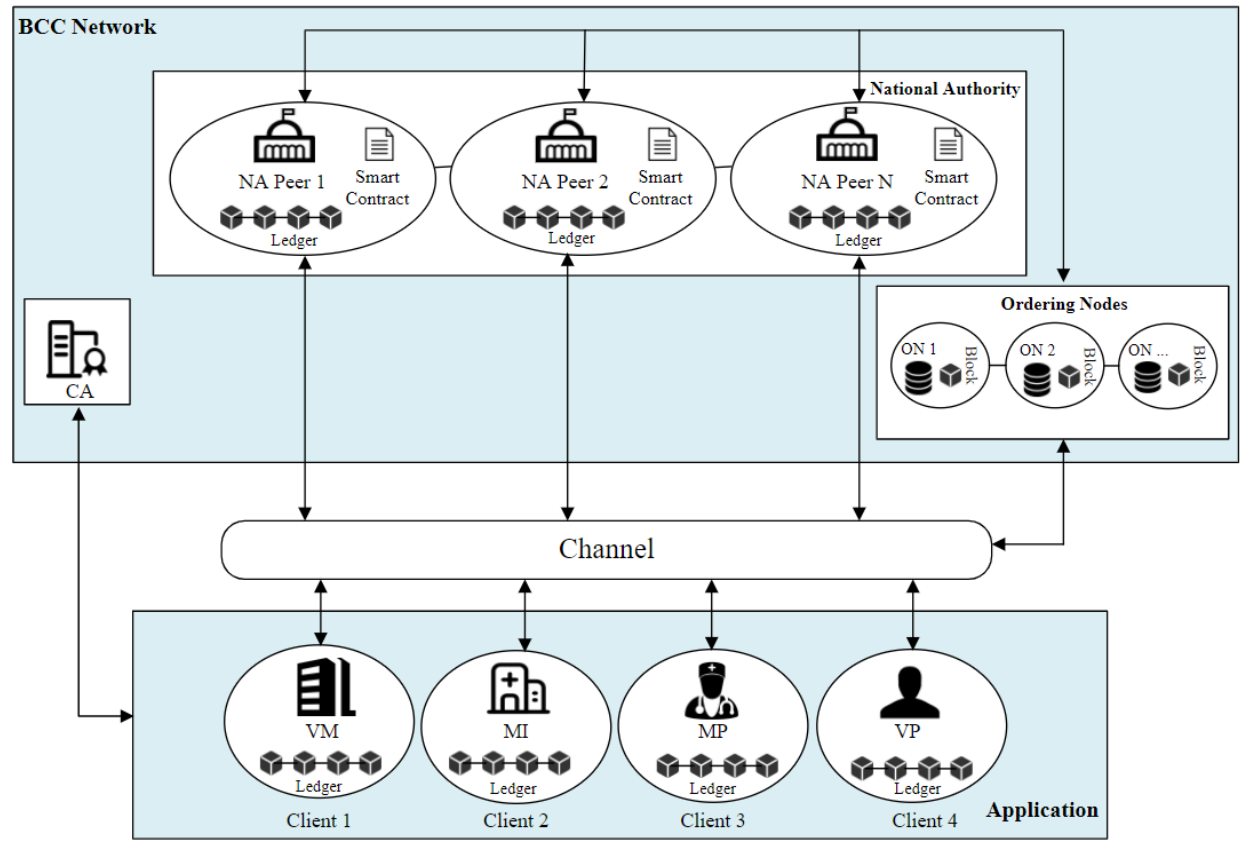
Figure 2. The architecture of the hyperledger fabric. Moreover, the key information of each role designed within the system will be defined in the smart contract to ensure that the system can authenticate spontaneously and operate properly afterward. Figure 3 shows the smart contract framework associated with the